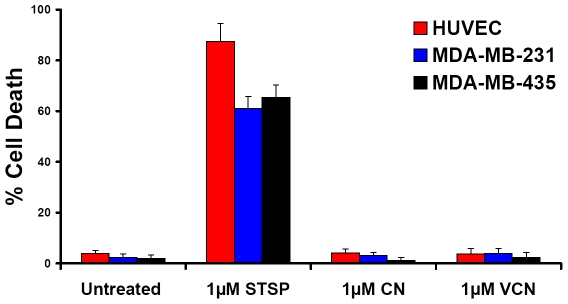
VCN does not affect the viability of cells plated on top of Matrigel.HUVEC, MDA-MB-231 or MDA-MB-435 cells were seeded in serum-free media in multiwell chamber slides on complete Matrigel and allowed to adhere for 1 hr. Once adherent, the cells were incubated for up to 48 hr with either CN or VCN up to a maximum concentration of 1 µM. Untreated cells or cells exposed to the apoptosis inducer Staurosporine (STSP) at a concentration of 1 µM were used as controls. The cells were fixed, TUNEL-stained and counterstained with Hoechst 33342. The amount of cell death was plotted for each condition by digitally counting the apoptosis events in random fields from images taken from multiple experiments for each condition.